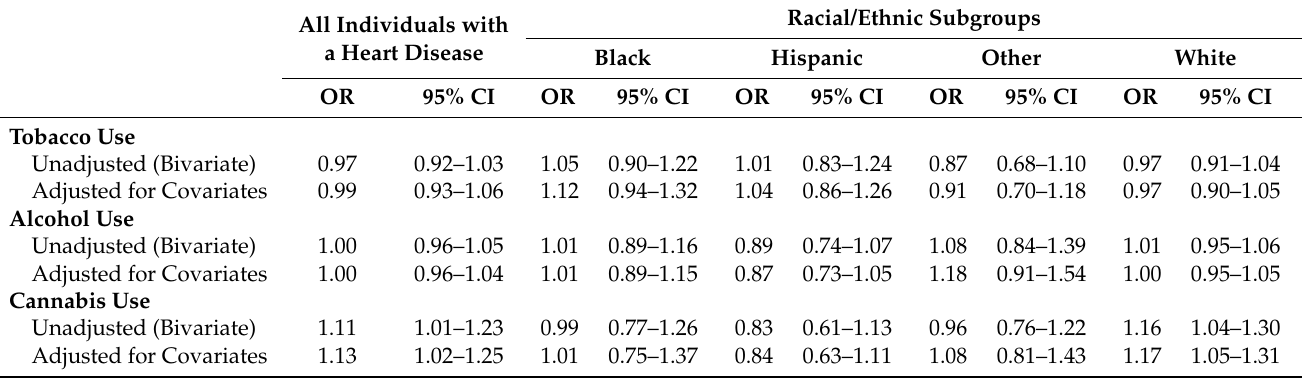
Table 2. Test of trends in tobacco, alcohol, and cannabis use among adults with heart disease: pooled sample of NSDUH 2015–2019.